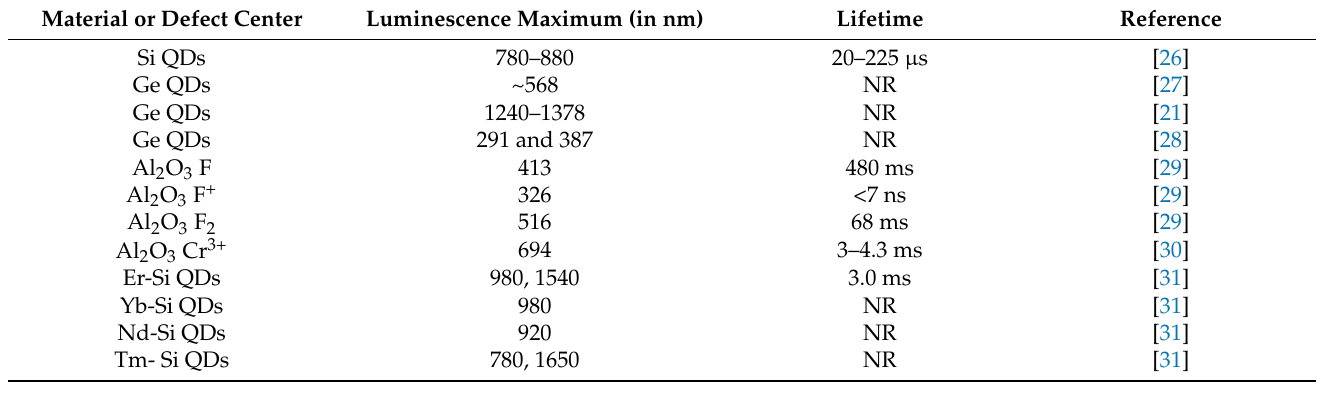
Table 1. Emission wavelengths and lifetimes for luminescent materials produced by ion implantation. NR stands for “not reported”. QDs stands for “quantum dots”.